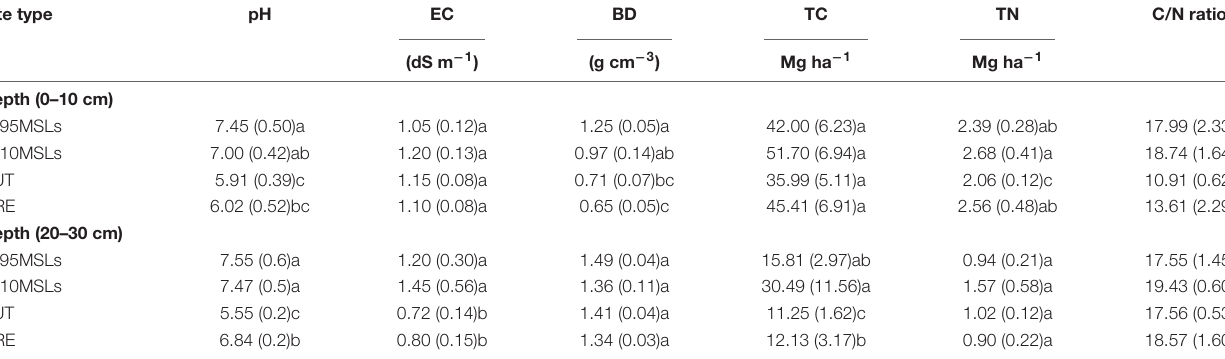
TABLE 3 | Bulk soil chemical and physical properties (means with standard errors in parentheses) at the 0–10 and 10–20 cm depth at each test site ( n =